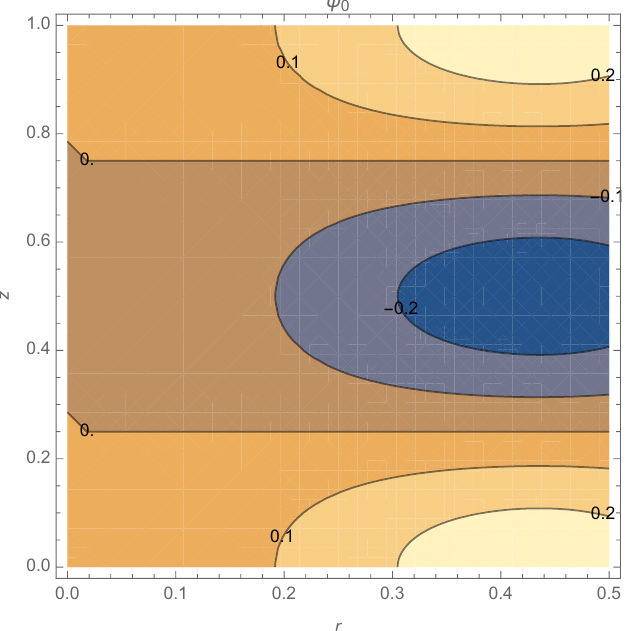
(cid:113) + 4 π 2 , case of the magnet. See text for details. x 2 02